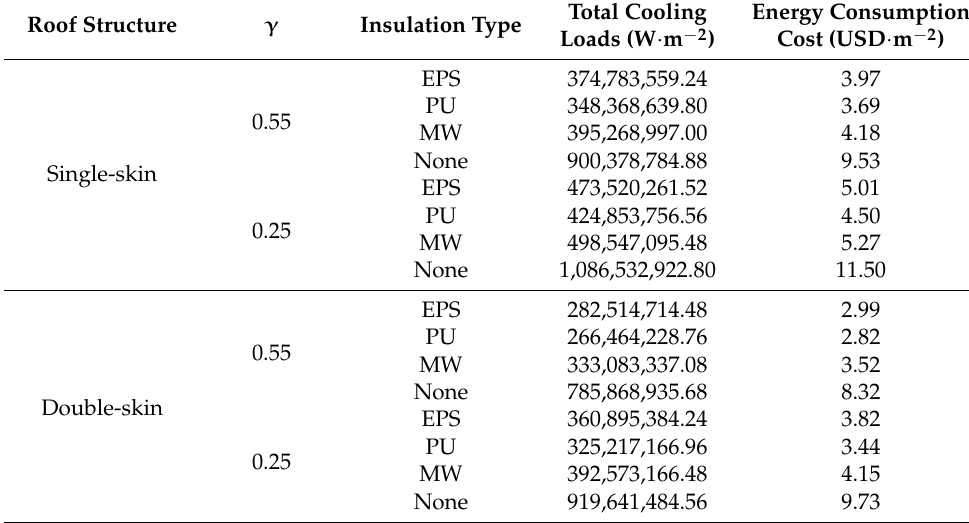
Table 4. The total cooling loads and energy consumption cost.